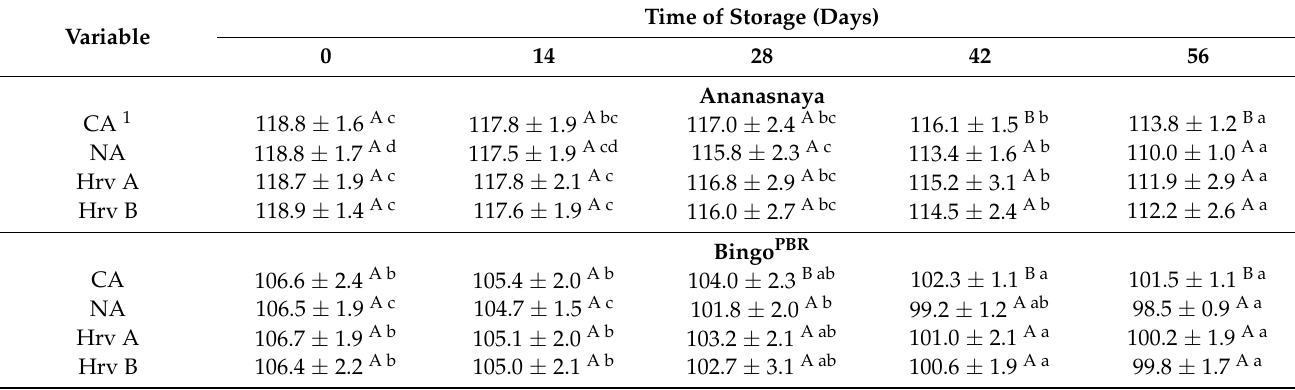
Table 6. Changes of skin colour [hue angle] measured in ‘Ananasnaya’ and ‘Bingo’ PBR minikiwi fruit in postharvest period.